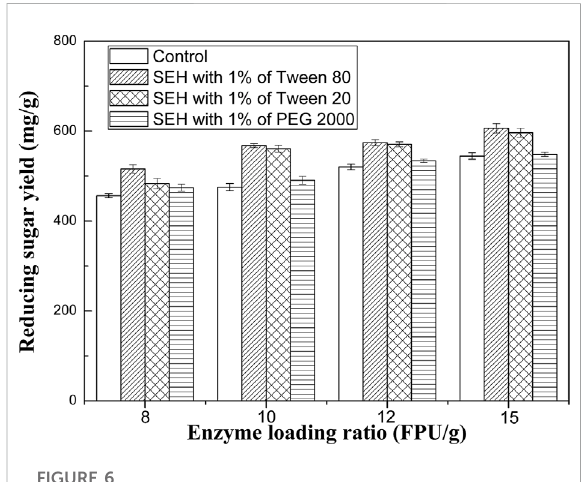
FIGURE 6 The effect of SEH of SAP sample on the fermentable sugar production.